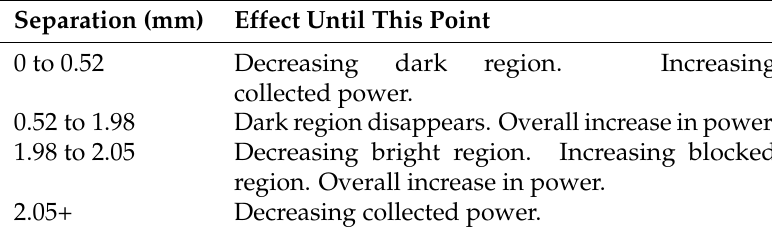
Table 2. Effects at critical